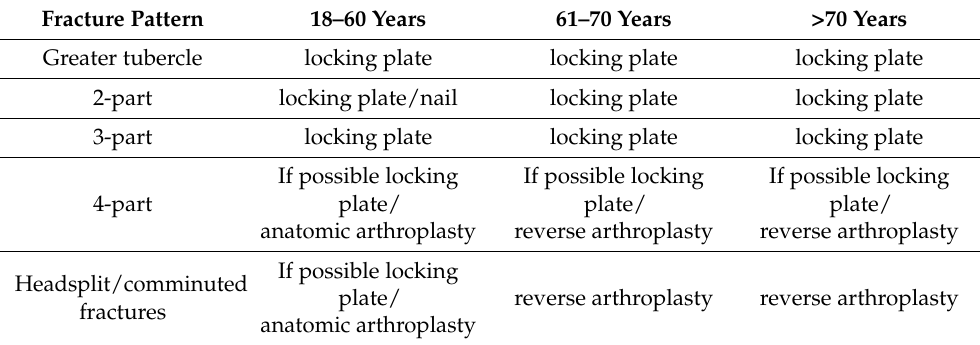
Table 1. Therapy Algorithm. Nondisplaced fractures were conservatively treated